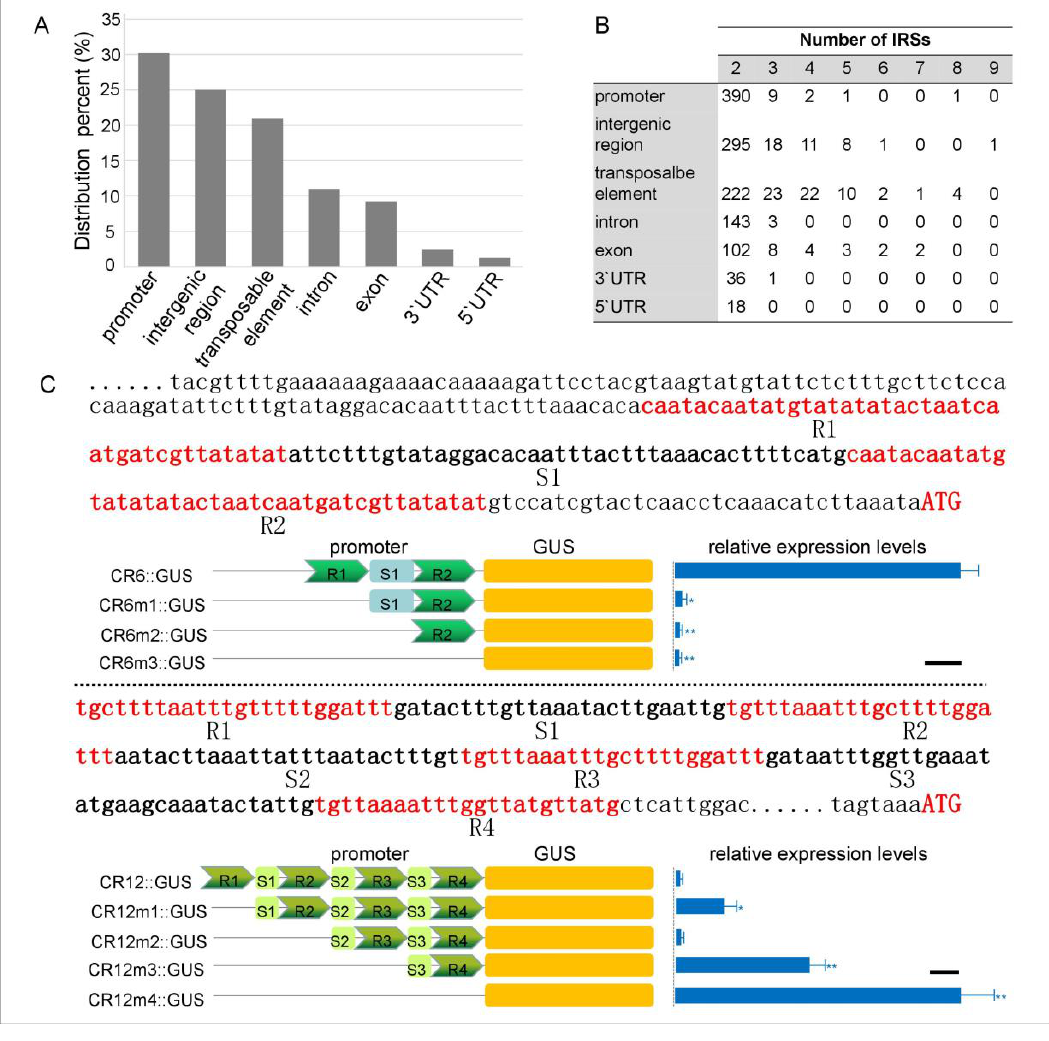
Figure 2. Distribution characteristics ( A ) and number ( B ) of Arabidopsis IRSs and regulation function analysis of IRSs in CR12 and CR6 promoters ( C ). Different repeat units and spacer sequences are identified in the form of R and S, respectively. The numbers behind R and S are helpful to distinguish them. The scale bar of GUS activity is 100 (4-MU pmol/mg protein/min). Significance was tested relative to each wild type using t -test. Significance of * p < 0.05 and ** p < 0.01. Error bar: standard